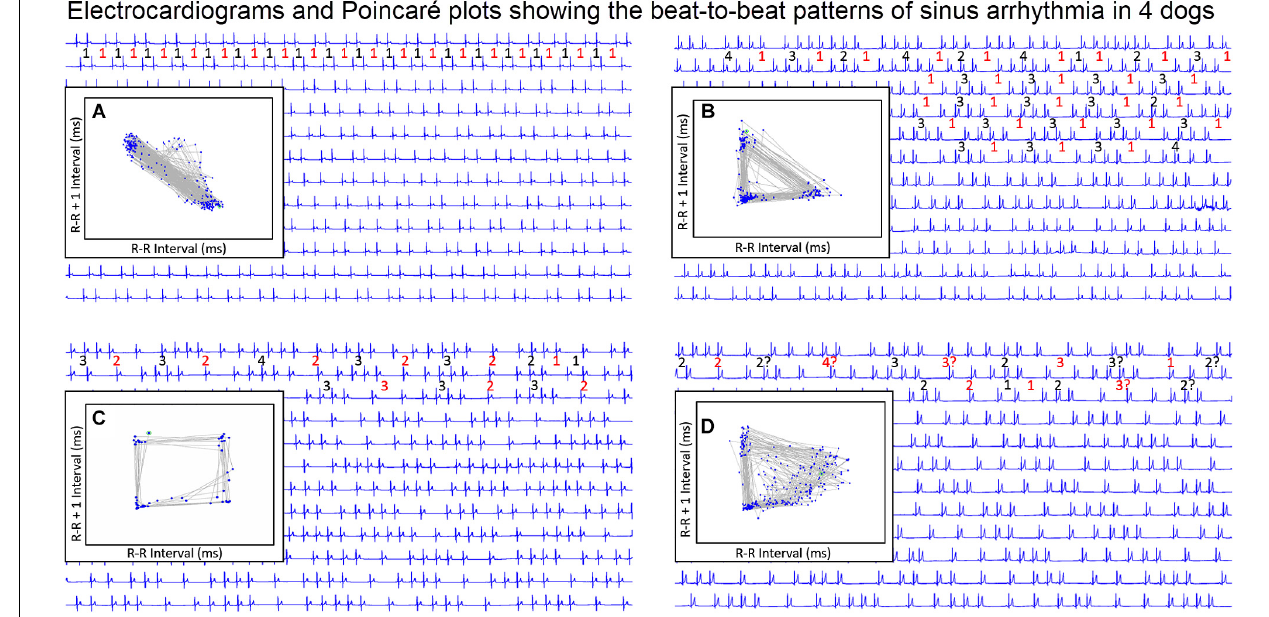
FIGURE 9 | During stable sleep hours, focused intervals were identified on the electrocardiogram and compared to the Poincaré plots. This figure illustrates four common patterns. Each line is 30 s. The inset is the Poincaré plot of the ECG frame shown (for clarity the specific R–R interval in milliseconds is omitted). Frame (A) shows the Poincaré plot when the sinus arrhythmia has primarily a ratio of one-short R–R interval to one-long R–R interval. Because there are no consecutive short-short R–R intervals, no clusters of intervals are seen in the lower left region of the Poincaré plot. Frame (B) shows the Poincaré plot when the primary ratio is one-long R–R interval to two to four-short R–R intervals. The short-short intervals are in the lower left region and the single long interval between the clusters of short intervals results in a triangular shape (long–short interval followed by short intervals followed by short–long interval). Frame (C) shows the pattern when the sinus arrhythmia has primarily two-long R–R intervals with clusters of short intervals. The long–long intervals result in a cloud in the upper right region beginning at the line of identity. The resulting shape is that of a polygon. Frame (D) illustrates the shape of the Poincaré plot with more variability in the R–R intervals creating a long–long cloud of intervals. From frame (D) the R–R intervals before the speeding of the rate are more variable than the long R–R interval that follows the short sequence. That is, with sinus arrhythmia the long interval after the faster rate is more consistent then the long interval before the faster rate. It is important to note that these examples were taken during a time when each of the dogs was displaying a sinus arrhythmia with presumed high parasympathetic tone and not interrupted by marked increases in sympathetic tone. Without a sympathetic surge note that none of the short-short intervals goes below a specific point. Although for clarity the scale is omitted, this was approximately 600 ms. This corresponds to the limit of the R–R interval seen on the R–R interval tachogram (see Figure 7 and Table 3 ). For each frame, the numbers in red are long R–R intervals and numbers in black are short R–R intervals. If a ‘?’ follows the number, this indicates that some uncertainty exists concerning the exact number of intervals defined as long or short (e.g., R–R interval duration is